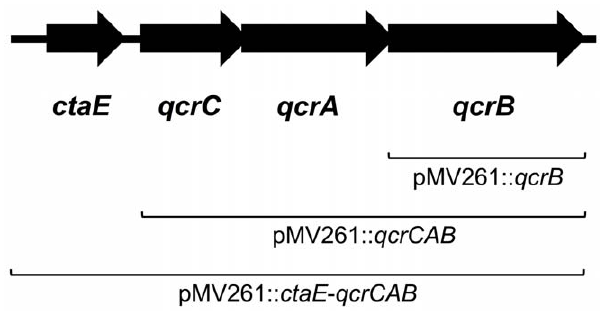
Figure 5. M.bovis BCG genome region harboring the genes for the cytochrome bc 1 complex and ctaE . The DNA regions cloned into the pMV261 vector are indicated.